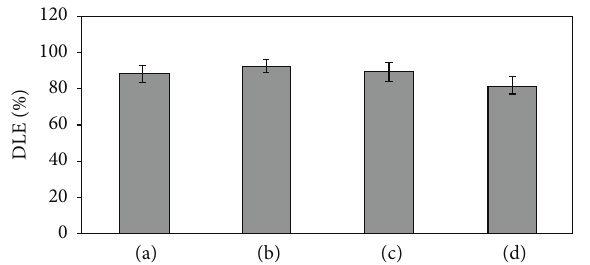
Figure 5: DLE of drug-loaded microspheres of (a) 15kDa chitosan, (b) 100kDa chitosan, (c) potato starch, and (d)